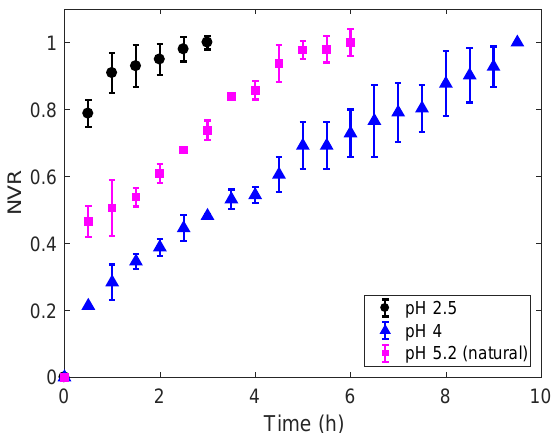
Figure 3. Release curves for the riboflavin encapsulated in freeze-dried 2% ( w / w ) gellan gums with different pHs. The vitamin content in the release medium is expressed as normalised vitamin released (NVR). Error bars correspond to triplicate tests.